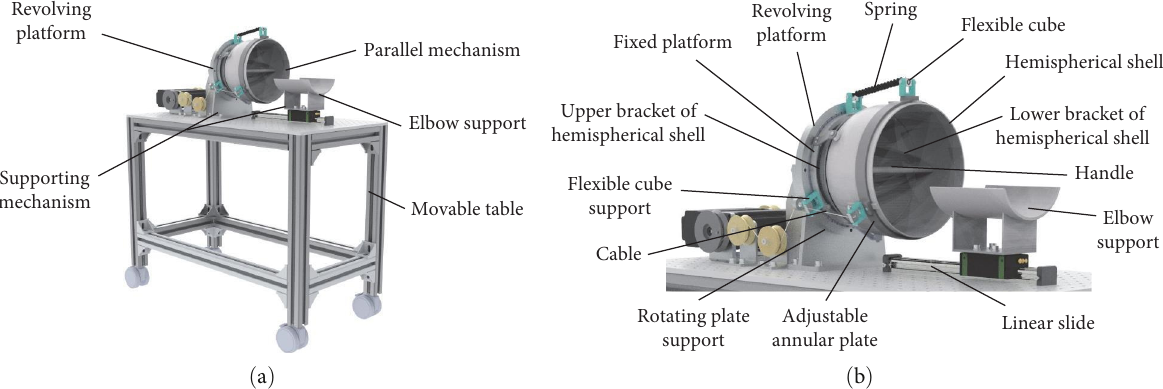
F IGURE 4: Three-dimensional model of cable-driven mechanism. (a) Oblique side view. (b) Detail